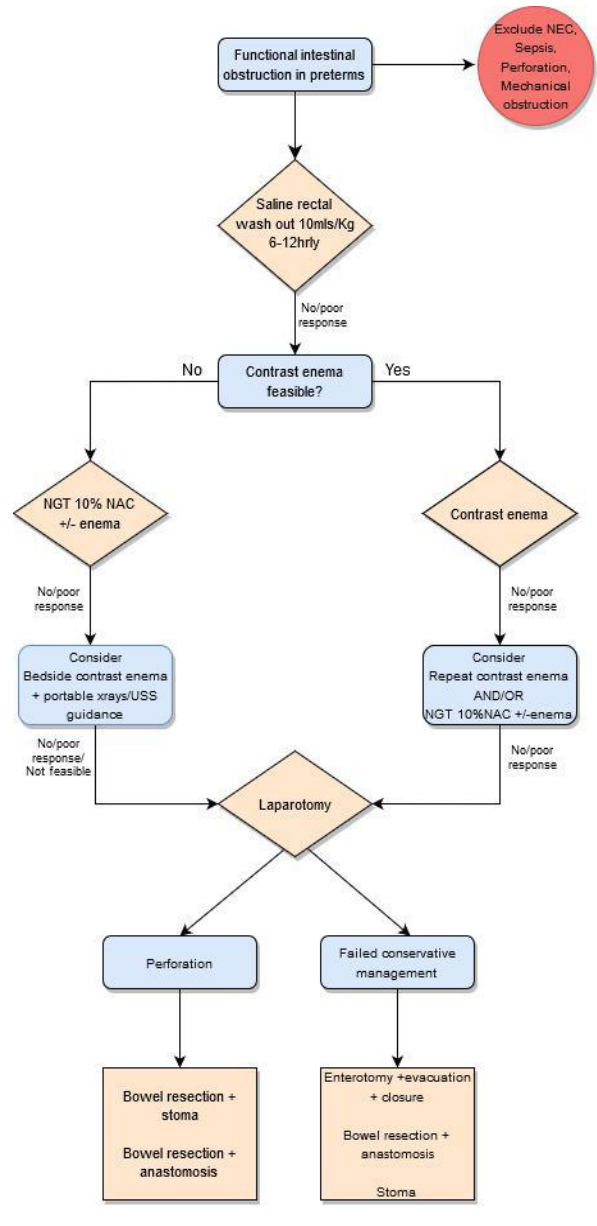
Figure 2: Flow chart of suggested conservative and surgical treatment approach Identify and manage complications : Fluid and electro- lyte abnormalities could occur with Gastrografin and NAC